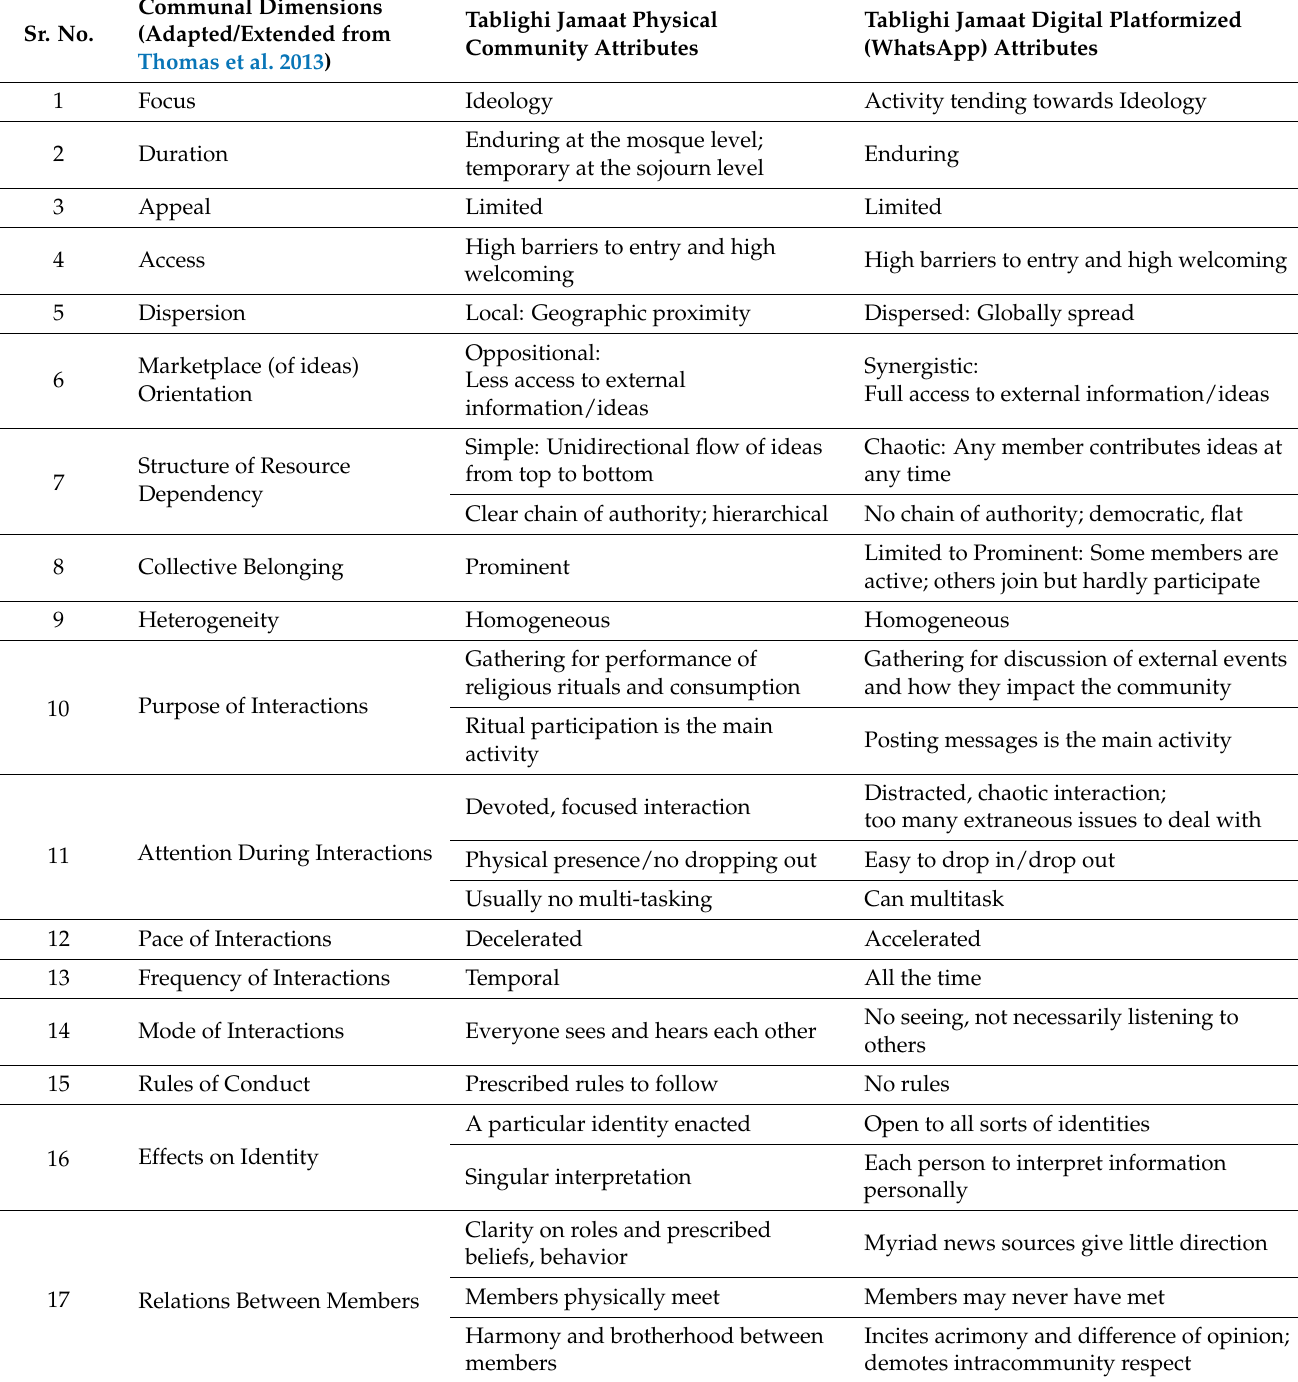
Table 2. Dimensions of